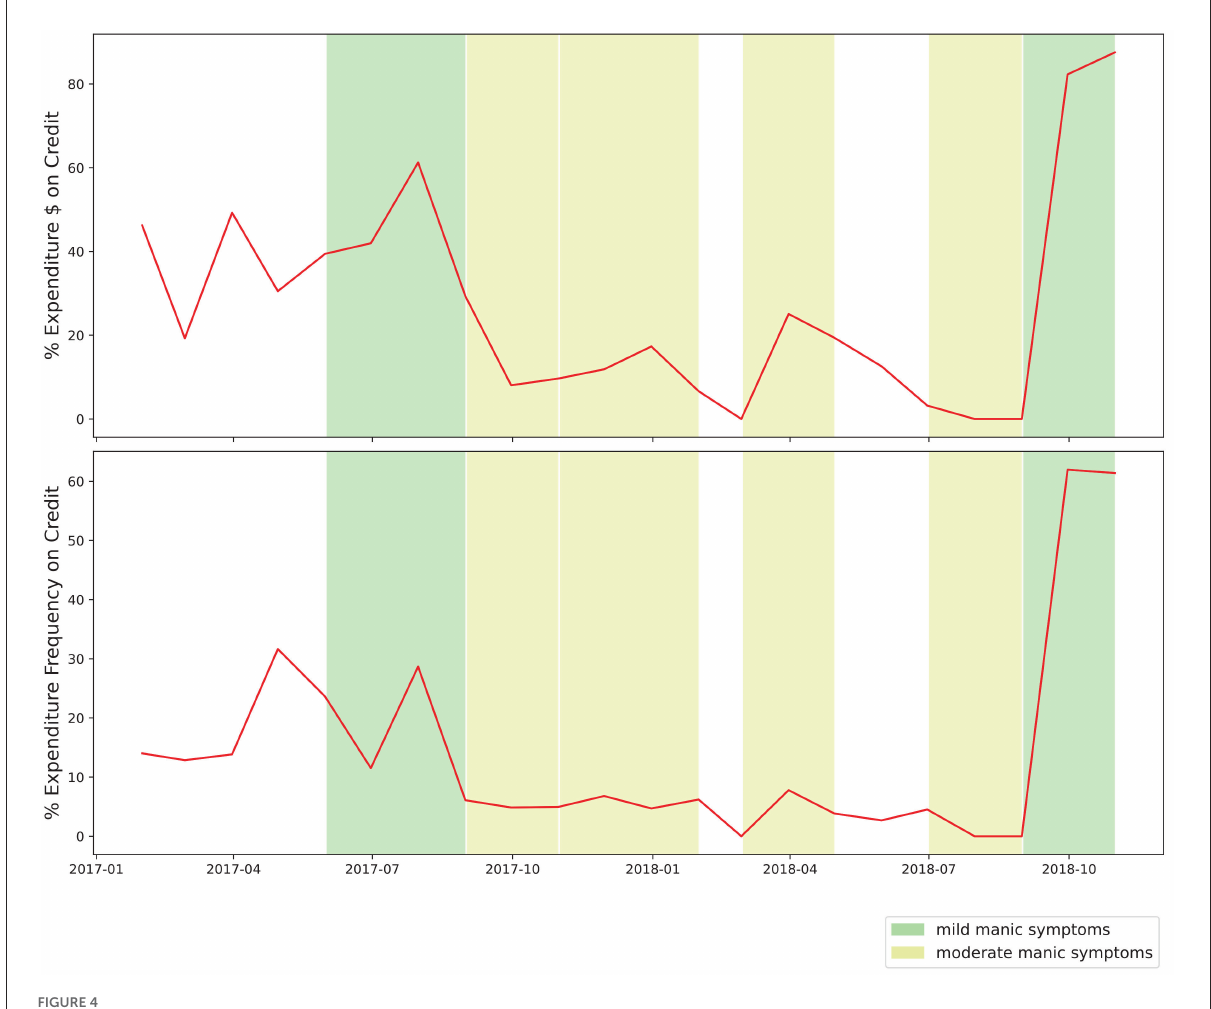
FIGURE4 Monthly percentage of purchases made on credit.